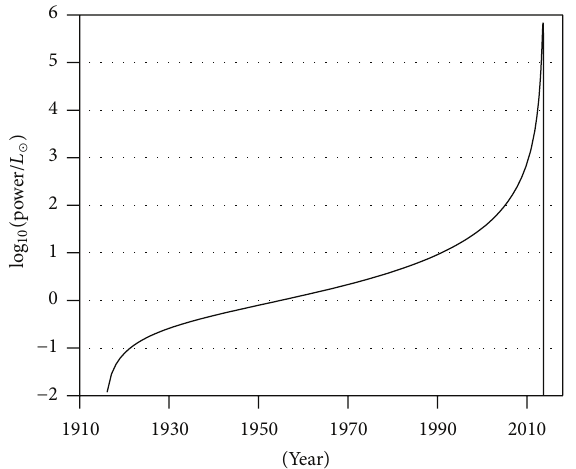
Figure 1: Simulation of the instantaneous power liberated by pion emission in the gas cloud G2, from apastron to periastron. 𝑀 = 𝜙 = 0 , and 𝑓 = 1 are 2𝑀 ⊙ , 0 𝑠